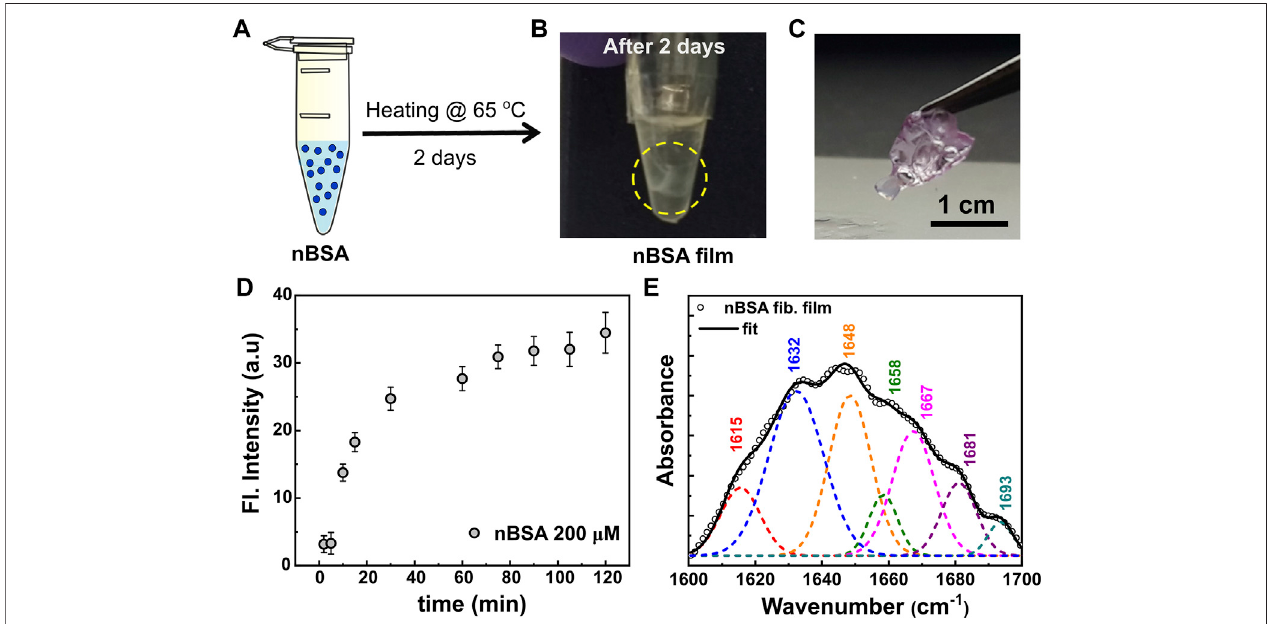
FIGURE6|(A,B) SchemeofnBSA fi lmformationfrom fi brils. (A) showsthenBSAmonomersinanEppendorftube,andtheformed fi lmafter2 daysofincubationis shown in (B) . (C) Pictorial representation oftheself-assemblednBSA fi bril fi lm.The fi lmisstainedwith Nilered dye for clarity. (D) Thio fl avin-T(ThT) fl uorescenceintensity curvefortheinitial120 minofnBSA fi lmformation. (E) Fourierself-deconvolutedFTIRspectrumoftheamideIregionofthenBSA fi lm,indicatingitspredominant β -sheet structure.